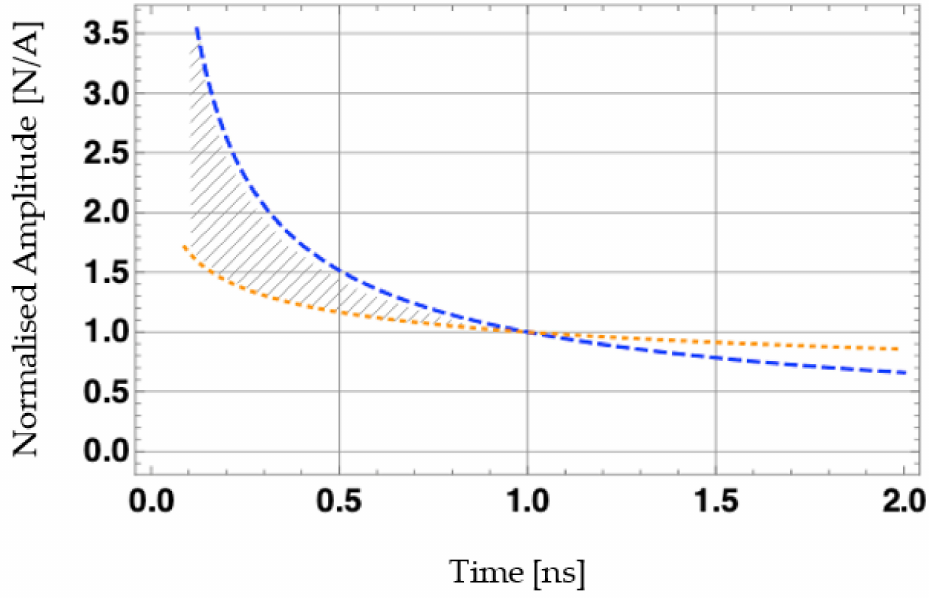
Figure 6. Comparison of the shockwave and heatwave velocities, v sw and v hw , for short time durations to a pulse width of 2.0 nanoseconds. Note that the shockwave (blue-dashed curve) initially outpaces the heatwave (orange-dotted curve), allowing for isentropic processing within the hashed